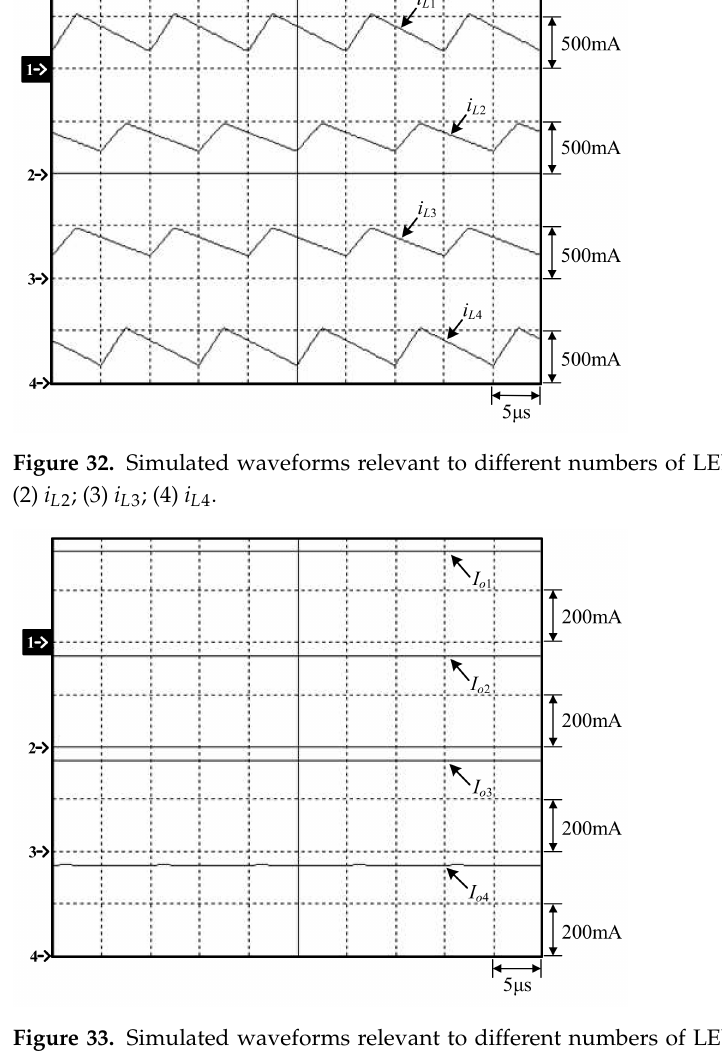
Figure 33. Simulated waveforms relevant to different numbers of LEDs for LED strings: (1) I o 1 ; (2) I o 2 ; (3) I o 3 ; (4) I o 4